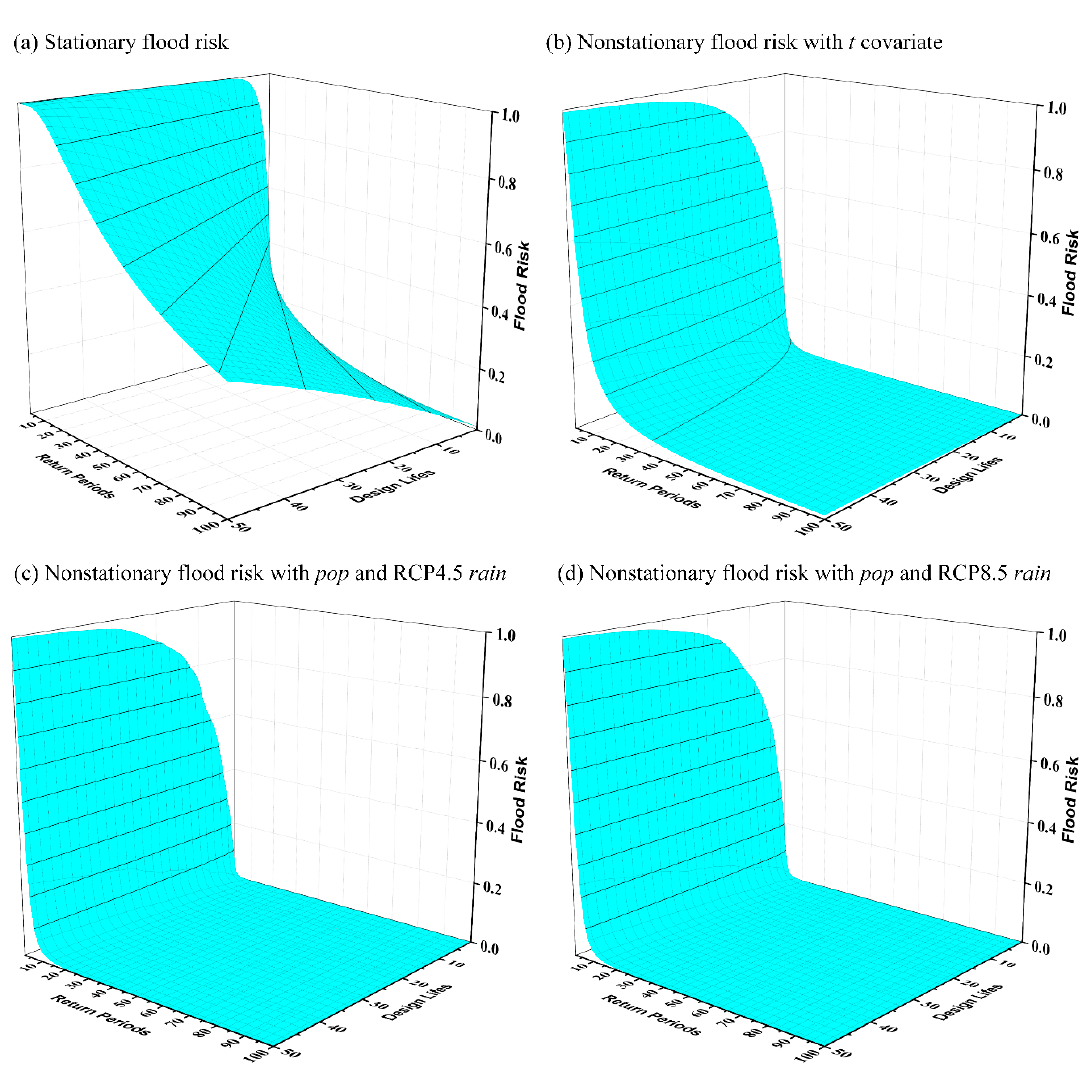
Figure 12. Stationary and nonstationary flood hazard of Huaxian station corresponding to return periods changing from 2 to 100, and design lifes changing from 1 to 50. ( a ) stationary flood hazard corresponding to design flood z q ; ( b ) nonstationary flood hazard calculated by nonstationary model with time covariate; ( c , d ) are nonstationary flood hazards calculated by nonstationary models with pop and rain covariates under RCP 4.5 and RCP 8.5 scenarios, respectively.